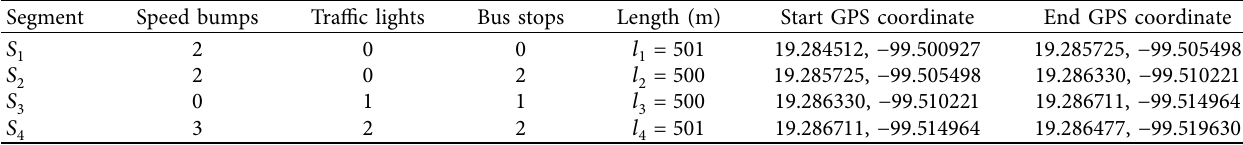
Table 1: Segment